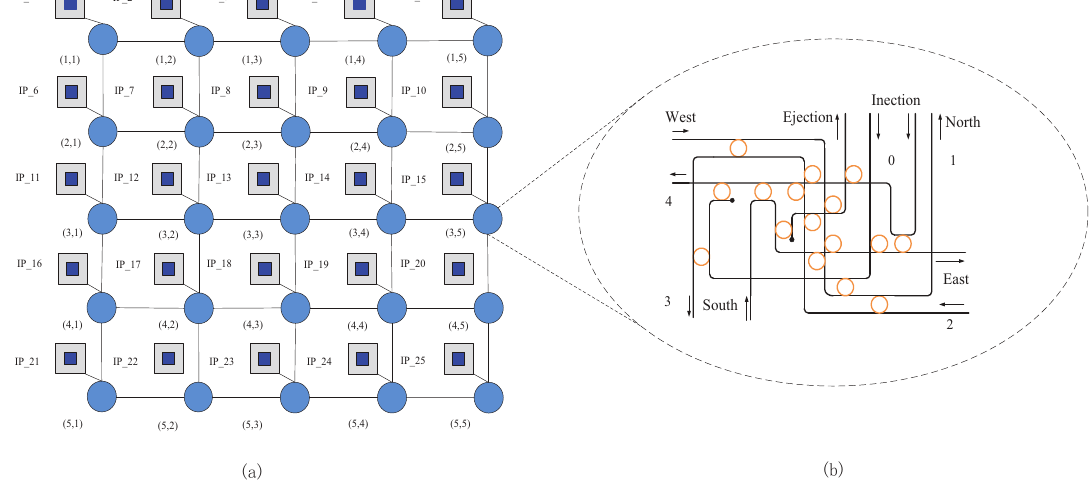
Figure 4. ( a ) The 5 × 5 mesh model based ONoCs ; ( b ) The internal structure of the